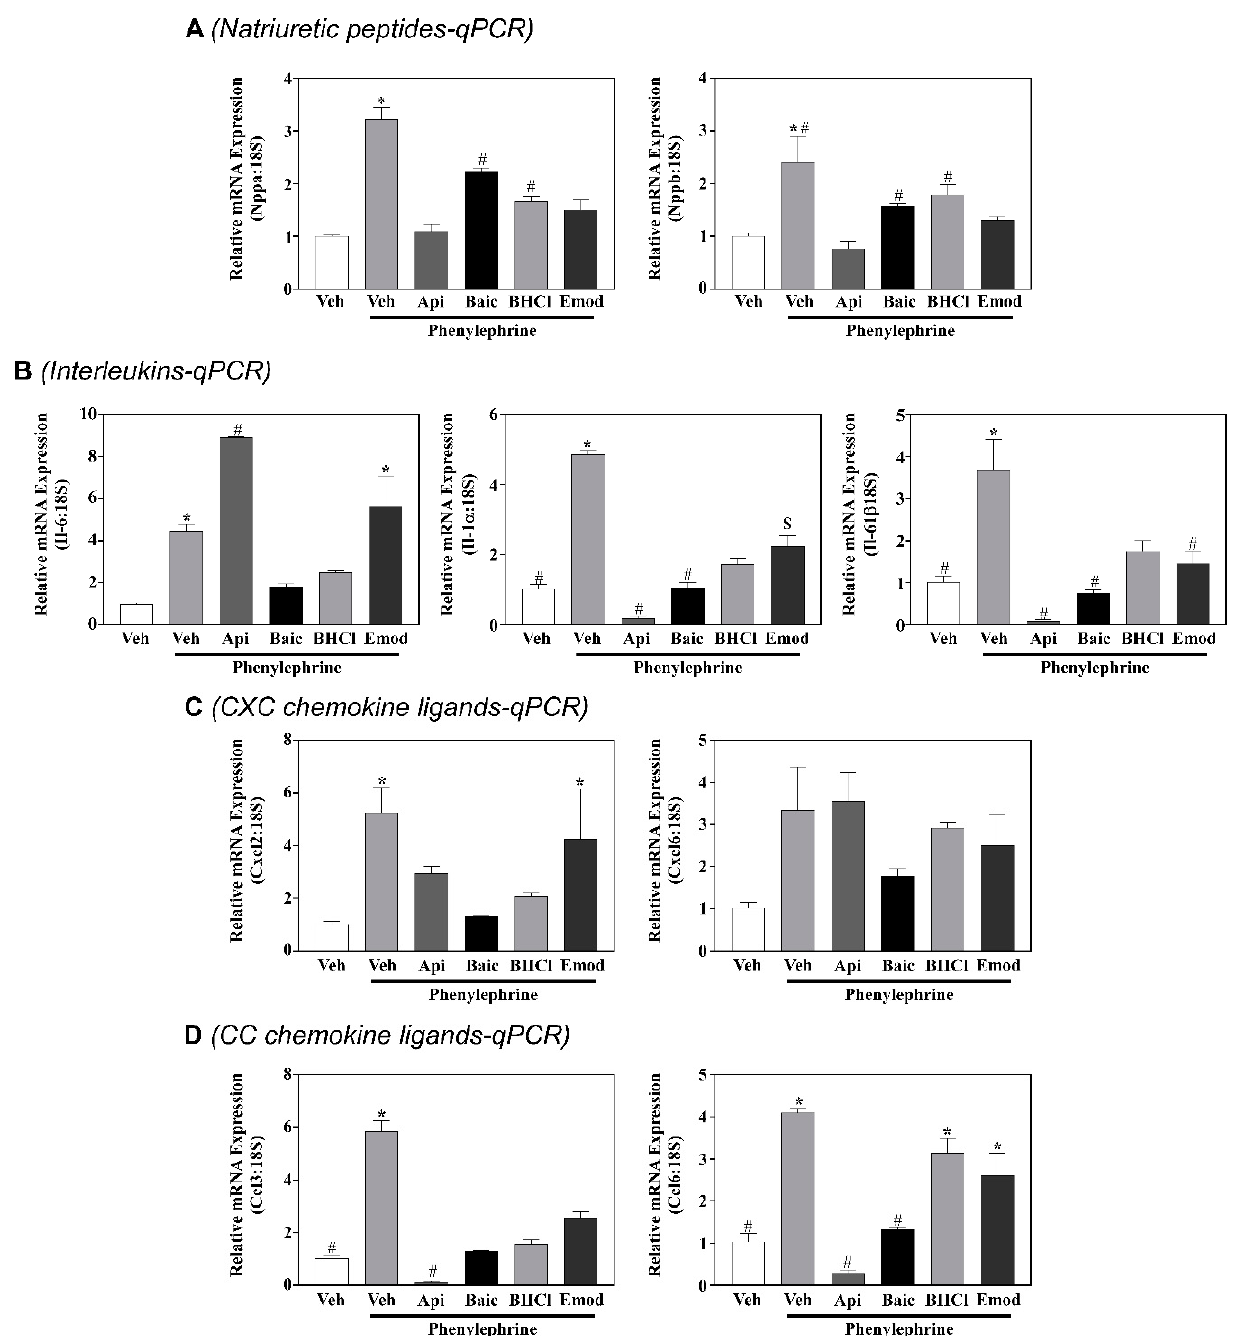
Figure 5. Phytochemicals regulate hypertrophic and inflammatory gene expression in NRVMs. Neonatal rat ventricular myocytes (NRVMs) were stimulated to hypertrophy with phenylephrine (PE; 10 µM) in the absence or presence of vehicle control (Veh) or phytochemicals (apigenin (Api), baicalein (Bac), berberine hydrochloride (BHCl), emodin (Emod); All compounds were used at 10 µM) for 48 h. RNA was isolated and qPCR performed to analyze the ( A ) natriuretic peptides (ANP and BNP), ( B ) interleukins (IL-6, IL-1 α , and IL-1 β , ( C ) CXC chemokine ligands (CXCL2 and CXCL6) and ( D ) CC Chemokine ligands (CCL3 and CCL6). 18S rRNA was used as our endogenous control and gene expression expressed using 2 −ΔΔ Ct . One-way ANOVA with Tukey’s post-hoc was used to determine significance ( p < 0.05). *—Significantly different from values not marked with an asterick, #—significantly different from phenylephrine, S—significantly different from apigenin.